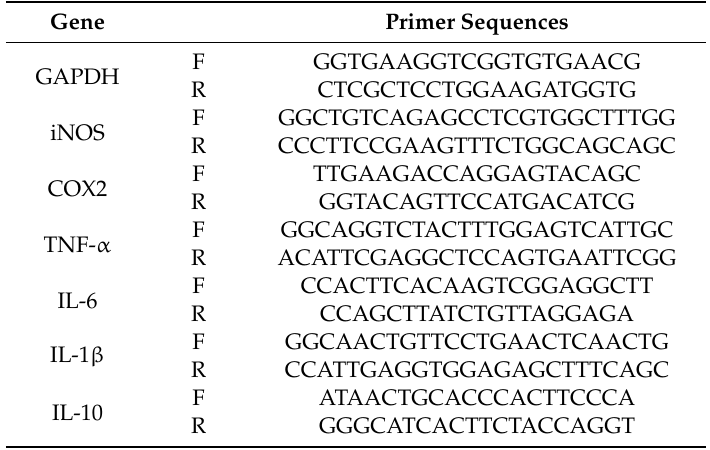
Table 1. Primers of the investigated genes in qPCR analysis. Gene Primer